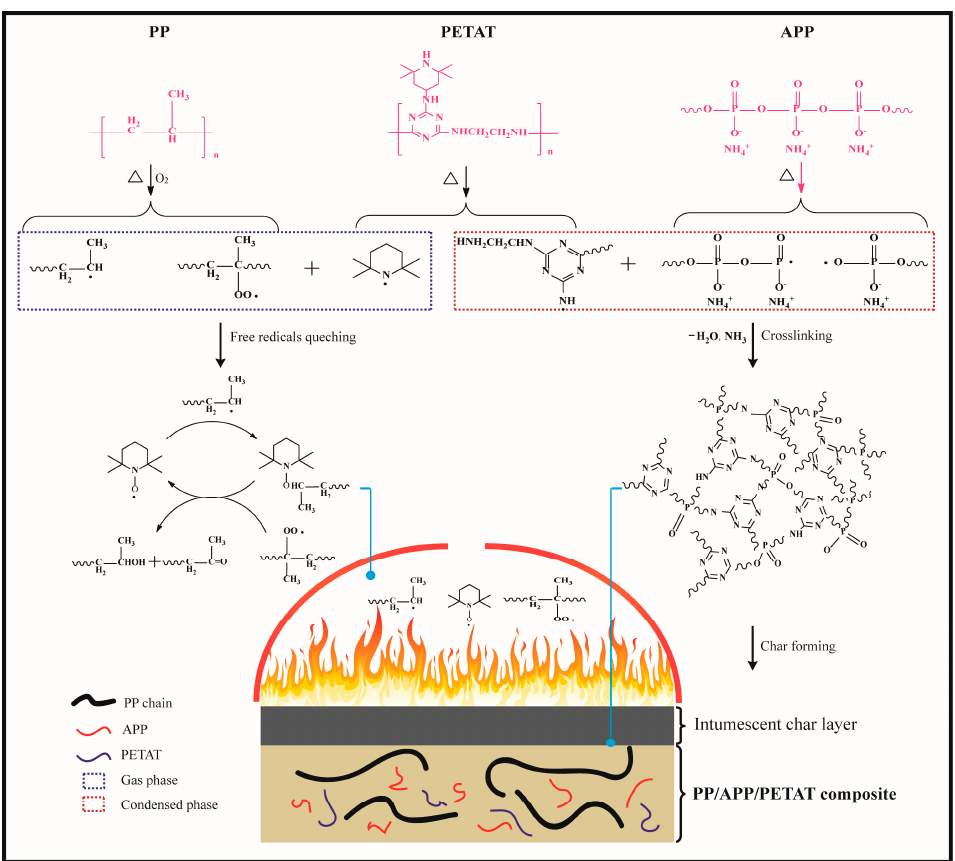
Figure 12. Flame retardant mechanism of PETAT/APP IFR system in PP matrix.